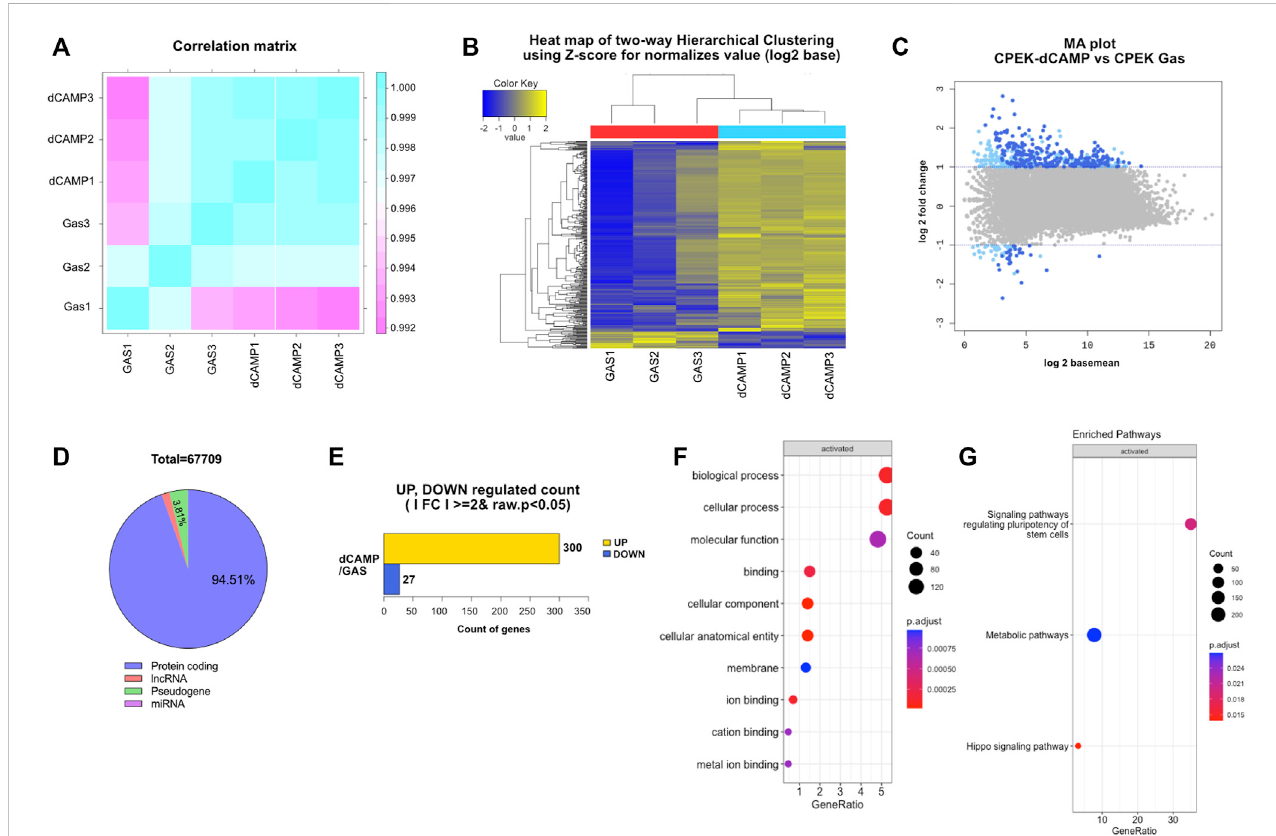
FIGURE 4 RNA sequencing analysis of 30-s dCAMP-treated CPEK cells compared with gas-treated cells. (A) Correlation matrix presents correlation coef fi cients between dCAMP-treated and gas-treated cells. The closer the correlation coef fi cient value is to 1, the higher the similarity between samples. (B) Two- dimensional hierarchical cluster analysis of differentially expressed genes between dCAMP-treated and gas-treated groups; an increase in expression is showninyellowhues,andreductionsareinbluehues. (C) MAplotshowstherelationshipbetweenthesigni fi canceofthedifferentialexpressiontest(log 2 fold-change) and mean-normalized expression between dCAMP treatment and gas treatment. Gray represents no signi fi cant change, light blue represents absolute log FC ≥ 2, and dark blue represents absolute log FC ≥ 2 and p -value < 0.05. (D) Total number of genes regulated by direct CAMP treatment. (E) Numberofgenessigni fi cantlyup-anddownregulatedbyCAMP-treatedcells.TheGOcategoriesfor (F) biologicalprocessand (G)